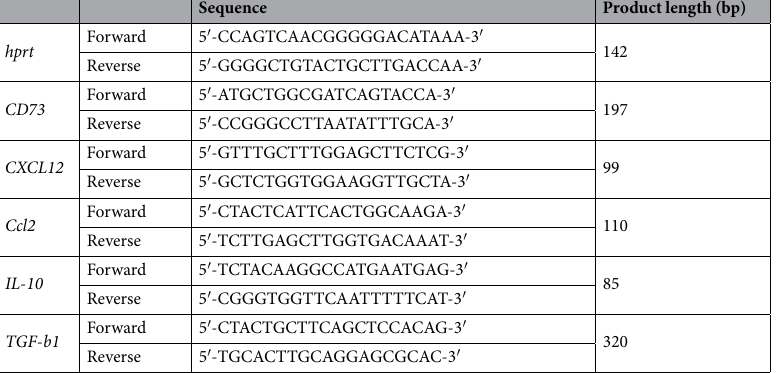
Table 2. Primer sequences for quantitative